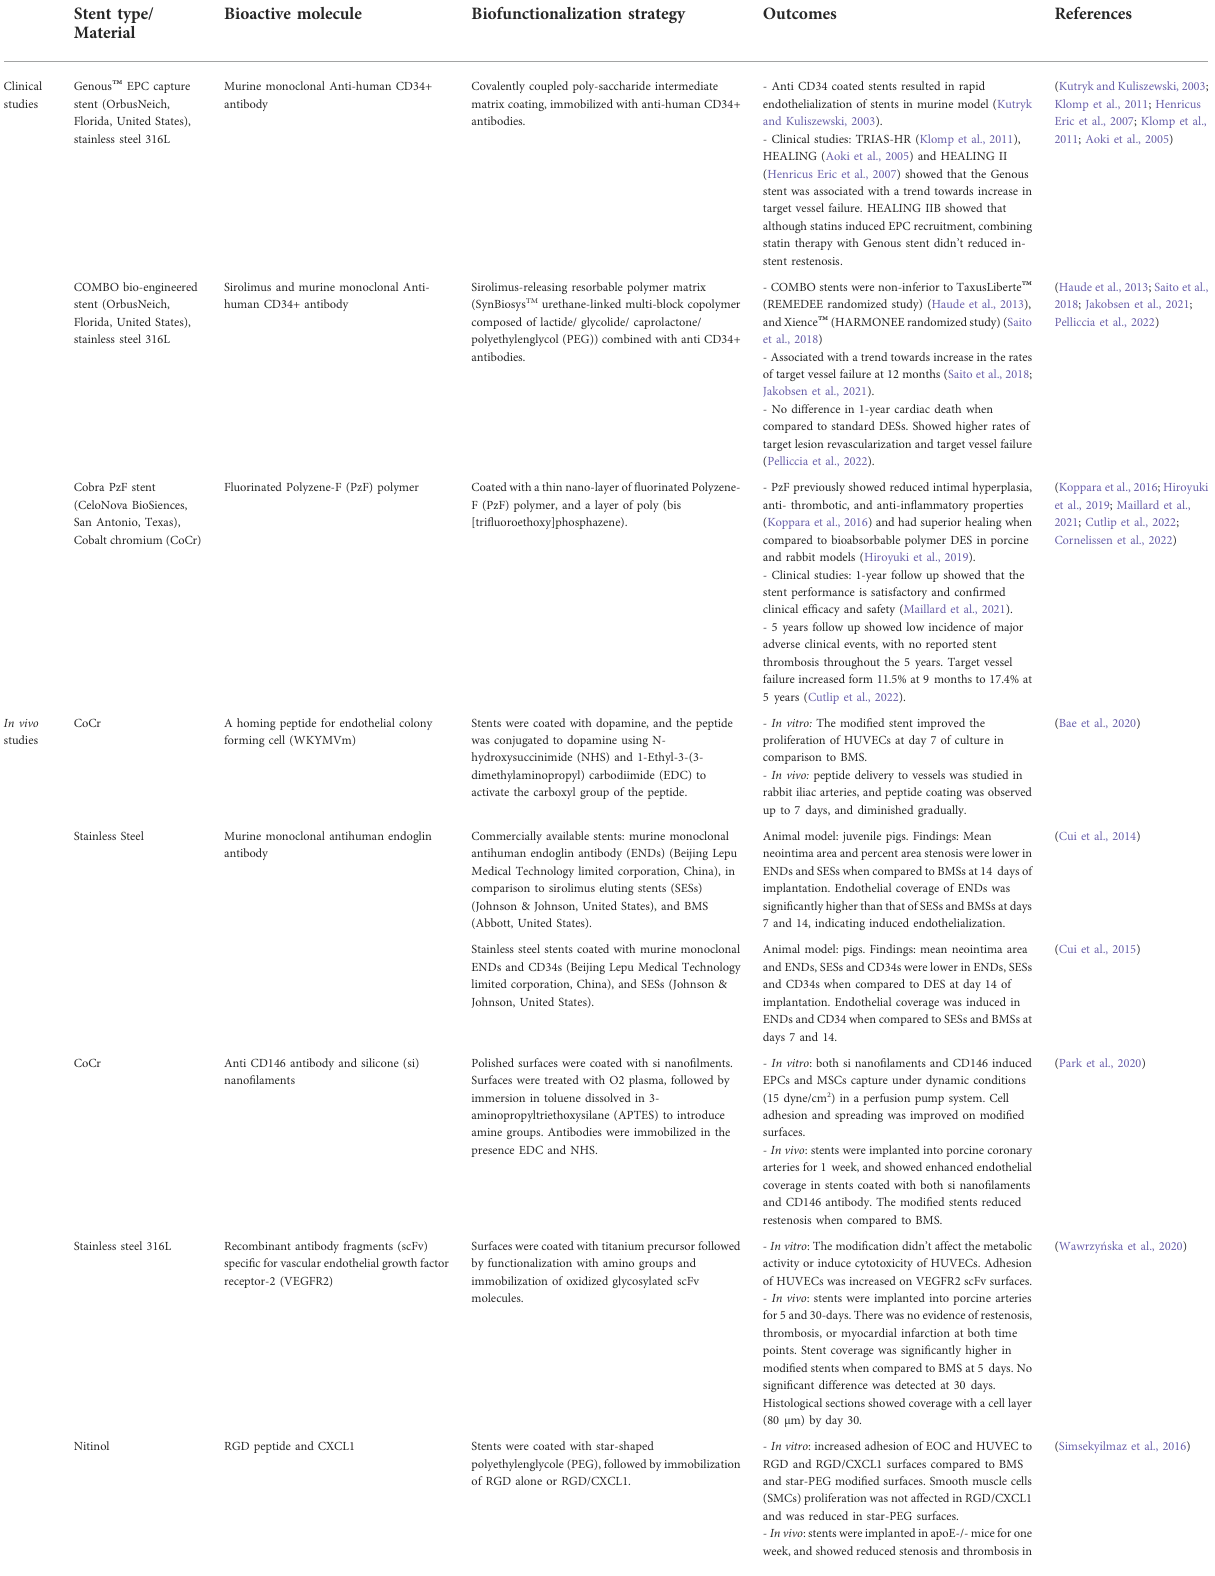
TABLE 1 Summary of the recent studies investigating the use of biomolecules to induce stent